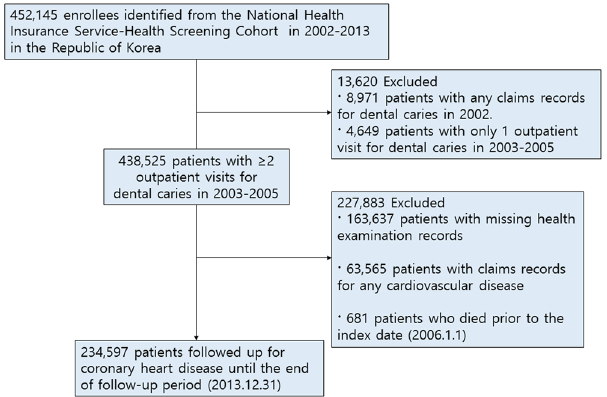
Figure 1. Flow chart of study population from the National Health Insurance Service-Health Screening Cohort database in the Republic of